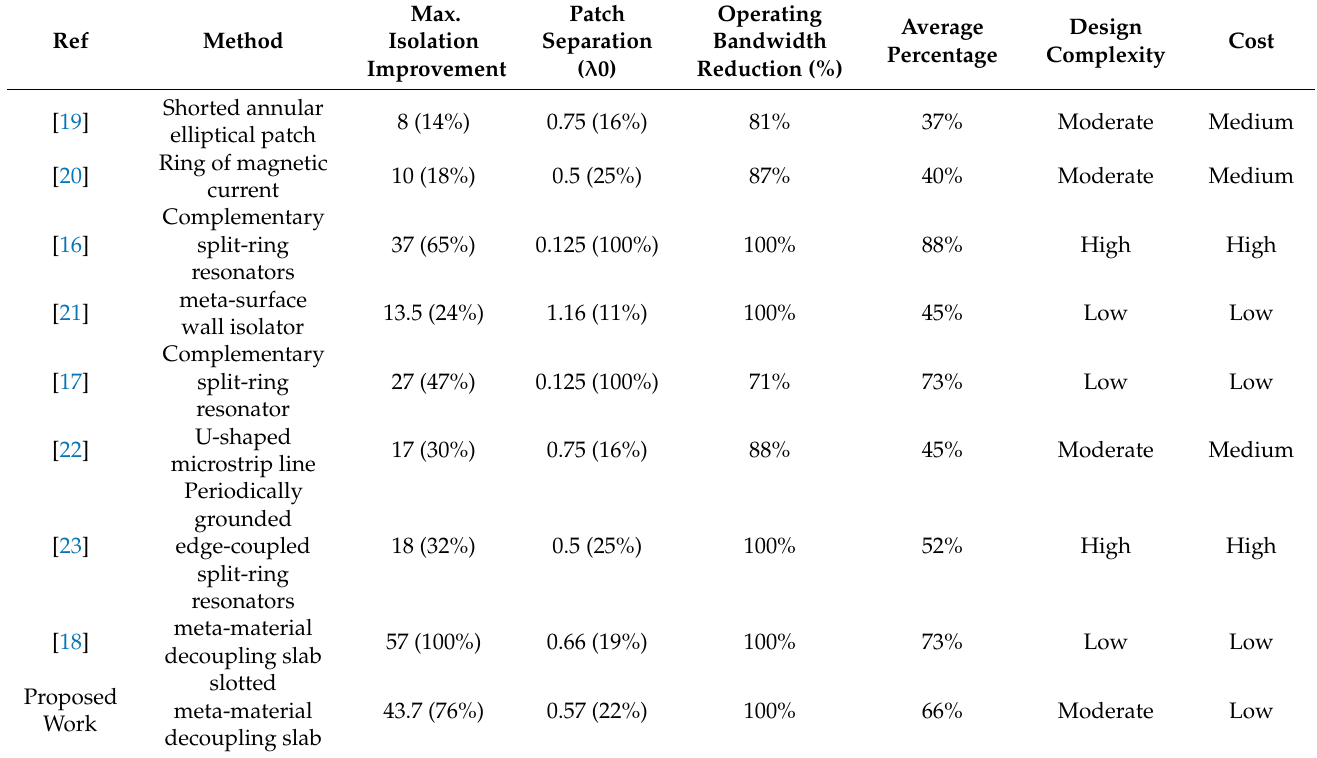
Table 3. Measurements resulted from the Three Isolating Techniques against previously presented work in the literature.